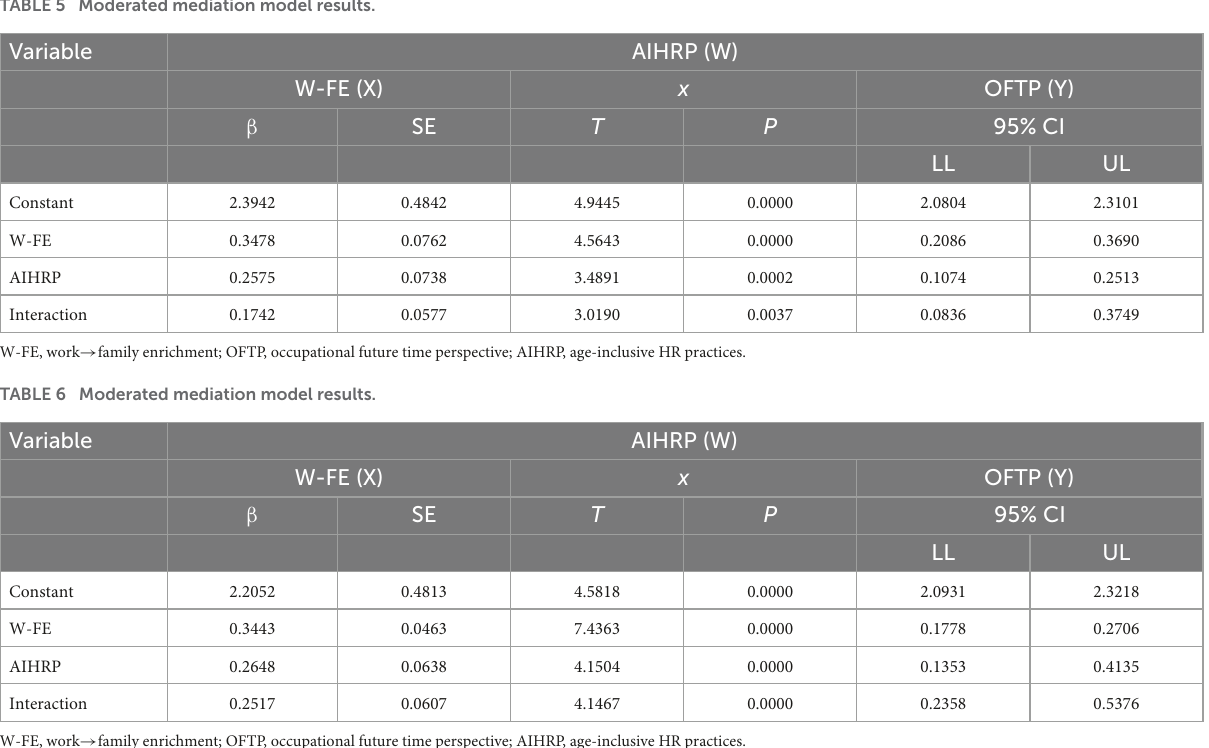
TABLE 5 Moderated mediation model results.